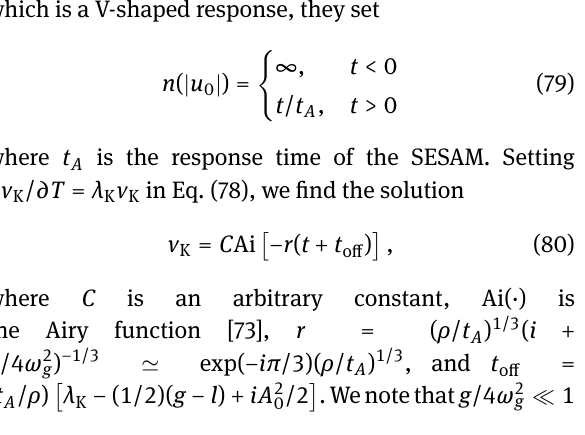
dow that is opened up by the slow saturable absorber, and we only show the central portion of their profile. In Fig. 4, by assuming t A = τ A , we compare, as τ A varies,